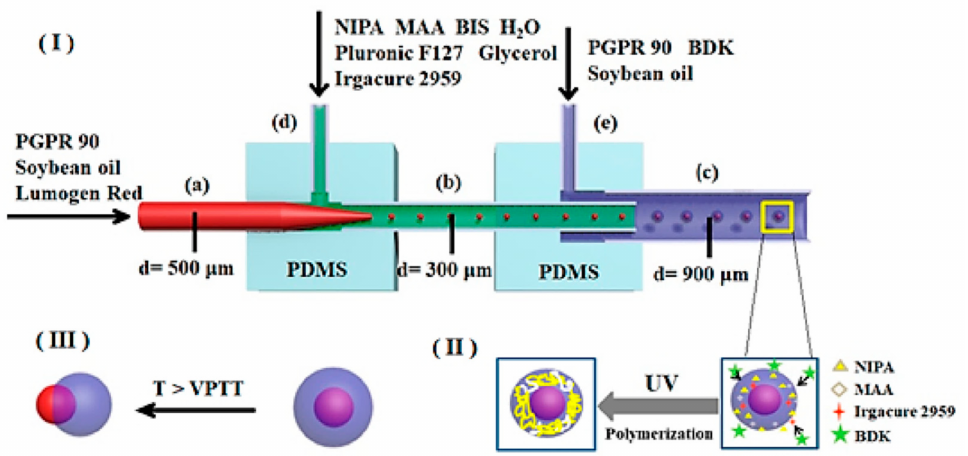
Figure 22. Schematic representation of microcapsules production via the microfluidic device used by Wang et al. ( a ) Glass capillary with an inner diameter of 500 µ m; ( b ) Glass capillary with an inner diameter of 300 µ m; ( c ) Collection tube; ( d , e ) Needles for fluid introduction. ( I ) Formation of O/W/O emulsion droplets on the chip; ( II ) UV-initiated polymerization of collected O/W/O emulsion droplets to form P(NIPA- co -MAA) microcapsules; ( III ) Thermo-triggered release behaviors of P(NIPA- co -MAA) microcapsules. Reprinted from an open-access source